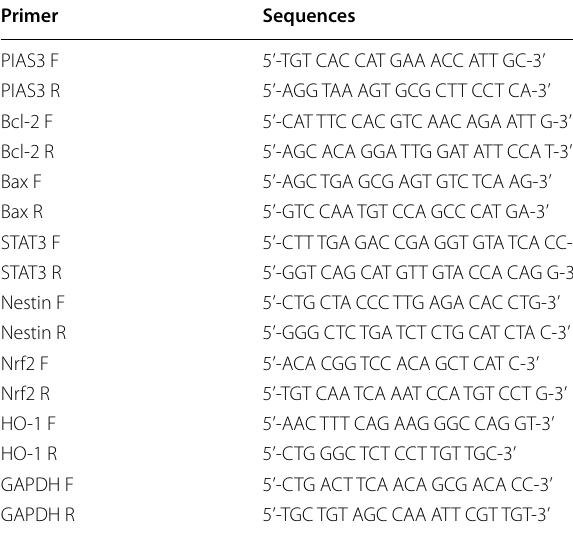
Table 1 The sequence of